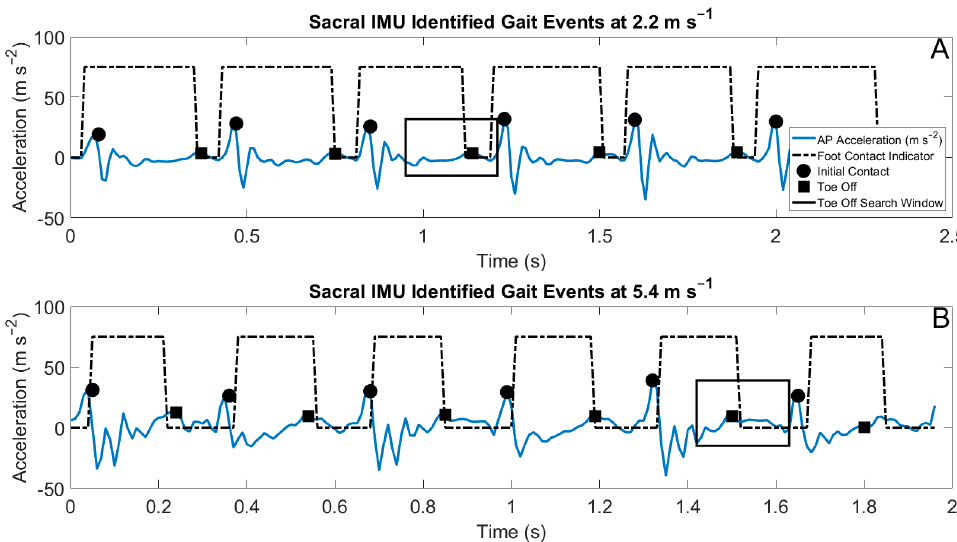
Figure 3. Acceleration waveforms from IMUs mounted on the sacrum (blue waveforms), with superimposed foot contacts (dashed black square waves) identified from the force-measuring insoles. The estimated IC sacrum is shown in the filled circles and the estimated TO sacrum is shown in the filled squares. The search windows used for the identification of TO sacrum are shown in the solid black rectangles. ( A ) Data from a 2.24 m s − 1 run; ( B ) data from a 5.36 m s − 1 run.